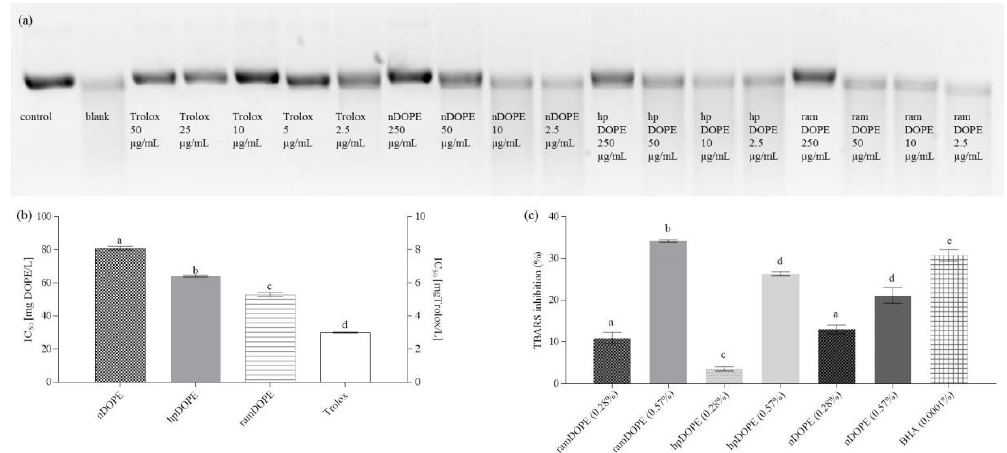
Figure 4. Inhibition of plasmid DNA strand scission and antioxidant activity of DOPE in liposome membrane model. ( a ): supercoiled (native) form of plasmid pBR322 DNA in electrophoresis gel